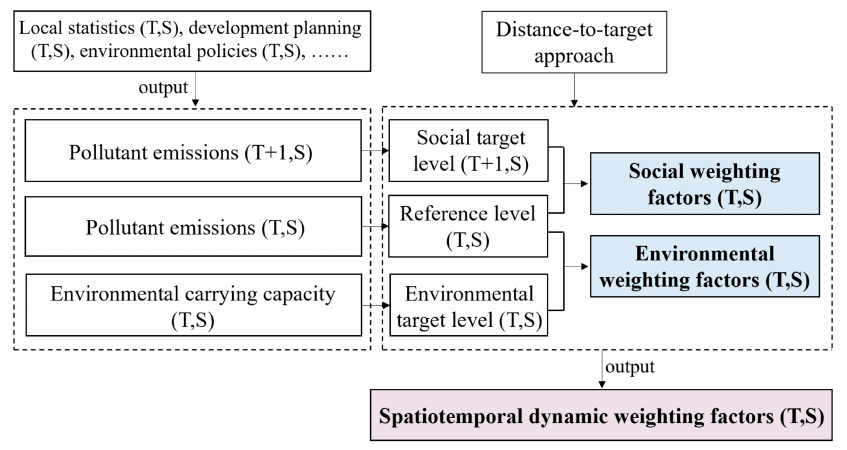
Figure 4. The dynamic model for spatiotemporal weighting